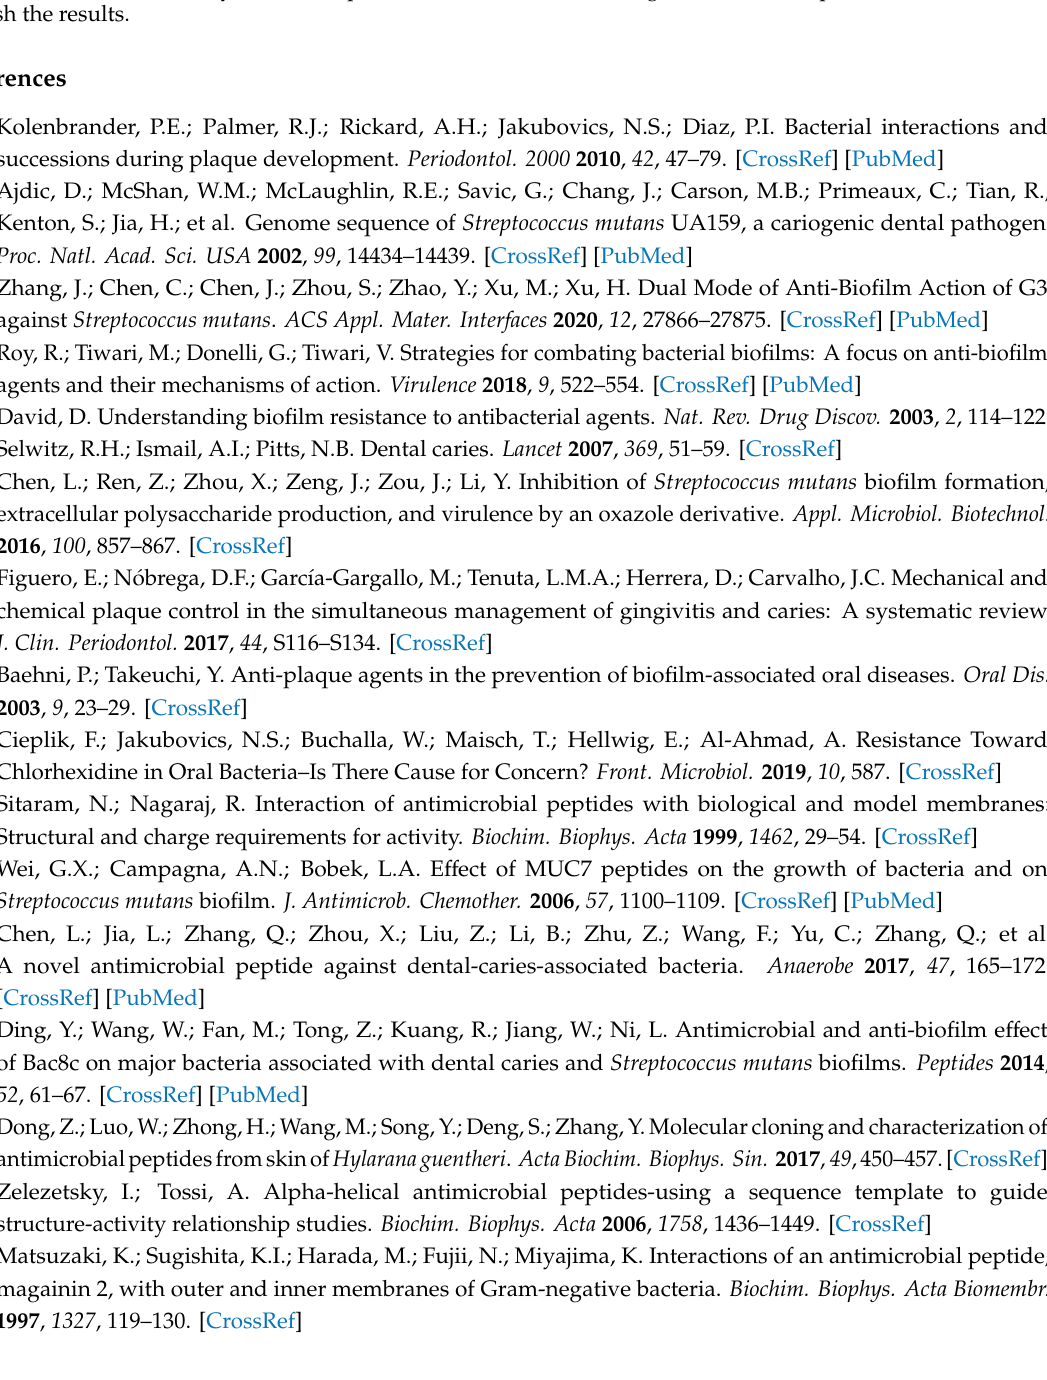
(A) and RP-HPLC chromatogram (B) of GHaR9R, Figure S6: The mass spectrum